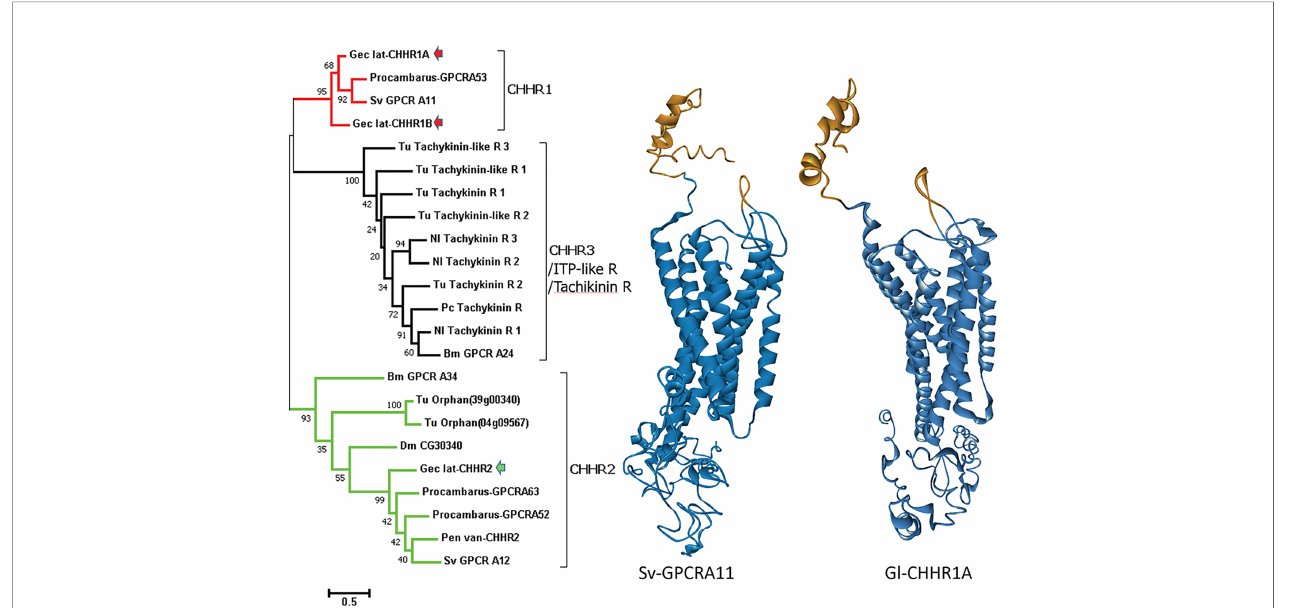
FIGURE 2 | Comparison of decapod putative CHH and insect and mite ITP-like/tachykinin GPCRs. Left: A phylogram (left) of arthropod neuropeptide GPCRs showing three clusters designated CHHR1 (red), CHHR2 (green), and CHHR3/ITP-like R/tachykinin R (black). G. lateralis (Gec_lat) CHHR1A and 1B, originally designated Gl-GPCR-A9 and -A10, respectively (25), are within the CHHR1 cluster (red arrows) and CHHR2, originally designated Gl-GPCR-A12 (25), is within the CHHR2 cluster (green arrow). Species: Bm, Bombyx mori ; Dm, Drosophila melanogaster ; Nl, Nilaparvata lugens ; Pen van, Penaeus ( Litopenaeus ) vannamei ; Procambarus, P. clarkii ; Sv, S. verreauxi ; and Tu, Tetranychus urticae (red spider mite). Right: Structural models comparing the putative CHHR1 proteins from two decapod species predicted by GPCR-I-TASSER (27): S. verreauxi (Sv-GPCRA11) and G. lateralis Gl-CHHR1A. Gold indicates the N-terminal neuropeptide binding cleft in the extracellular domain. Blue indicates the transmembrane domain containing the 7 a -helices characteristic of GPCRs and the C-terminal intracellular domain. Figure provided by Dr. Tomer